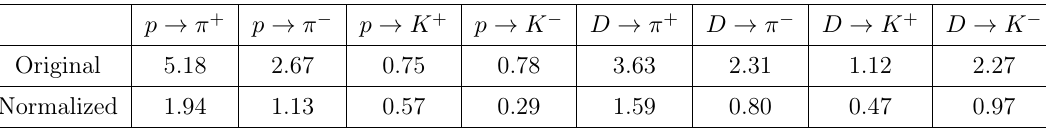
Figure 10 . Kinematic dependence of C.L. envelope of the full sets of best-fit curves. The data used in the fit approximately cover the range 5 10 (cid:0) 3 . x . 0 : 5 and 0 : 2 . z . 0 : 7 . (cid:2)